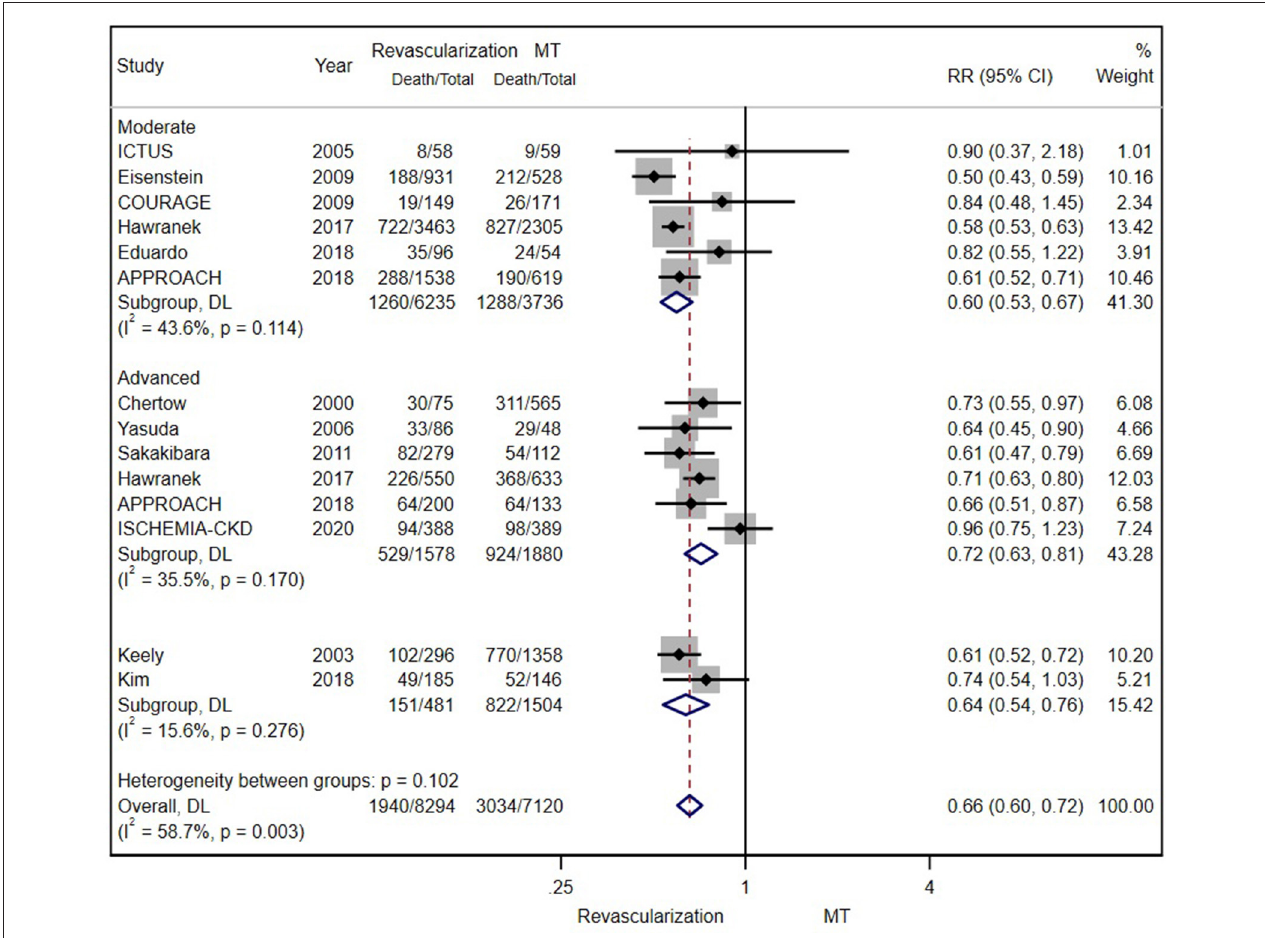
FIGURE 2 | The pooled effect of revascularization and medical treatment (MT) alone on the long-term mortality of patients with coronary artery disease (CAD) and chronic kidney disease (CKD). The pooled estimate of the meta-analysis was represented with a diamond. Revascularization was more effective than MT in reducing mortality in patients with CKD. Weights and between-subgroup heterogeneity test are from random-effects model.